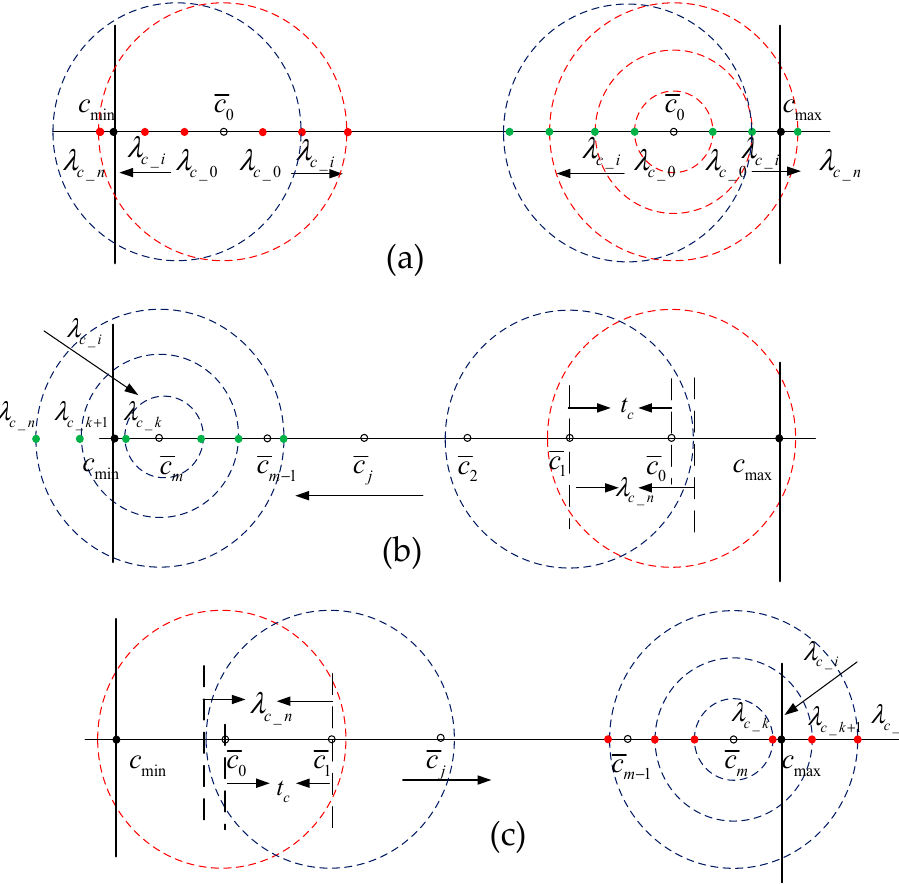
Figure 9. Process employed to identify the upper/lower bounds of a single uncertainty parameter. ( a ) finding a boundary for an uncertainty parameter and determining its type; ( b ) searching for the lower bound; ( c ) searching for the upper bound.